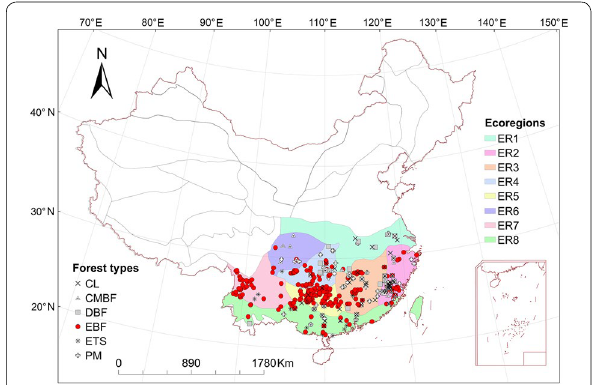
Fig. 1 The sampling plot locations for the six forest types in the subtropical region of China. See Table 1 for the abbreviations of the forest types and